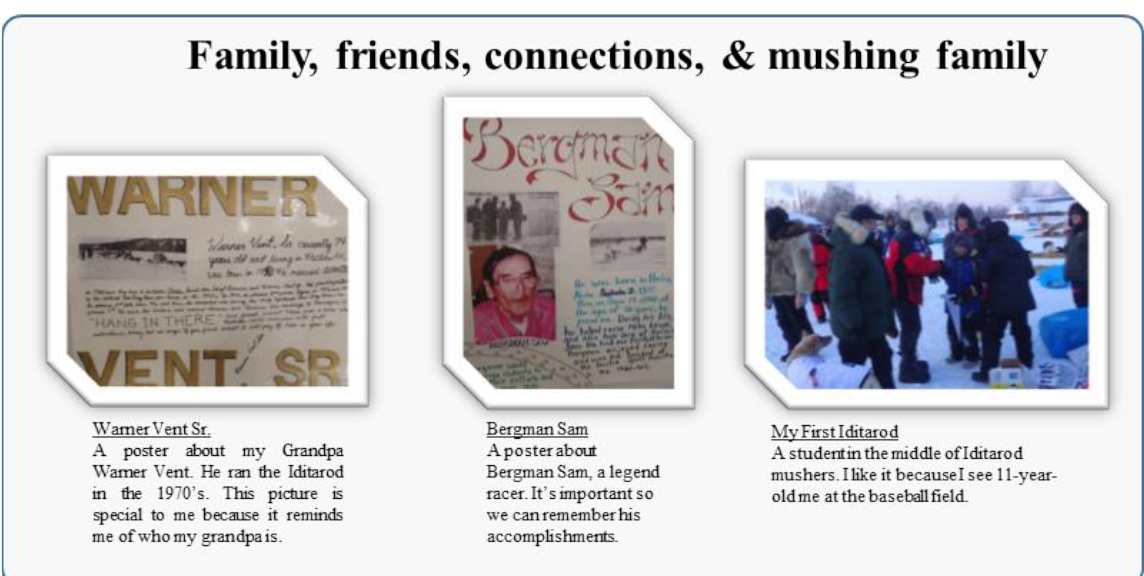
Figure A1. Photovoice themes “Getting to know the dogs” and “Family, friends, connections & mushing family”. The text under each picture is the title and description written by the youth participant to describe their picture. The blue emphasized quotes around the themes correspond to comments posted by youth participants upon discussion.